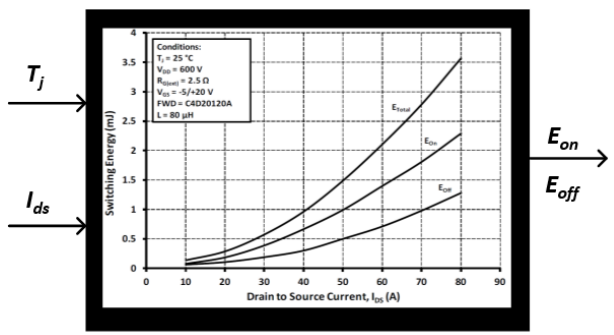
Figure 13. Lookup table to determine energy loss of MOSFET.